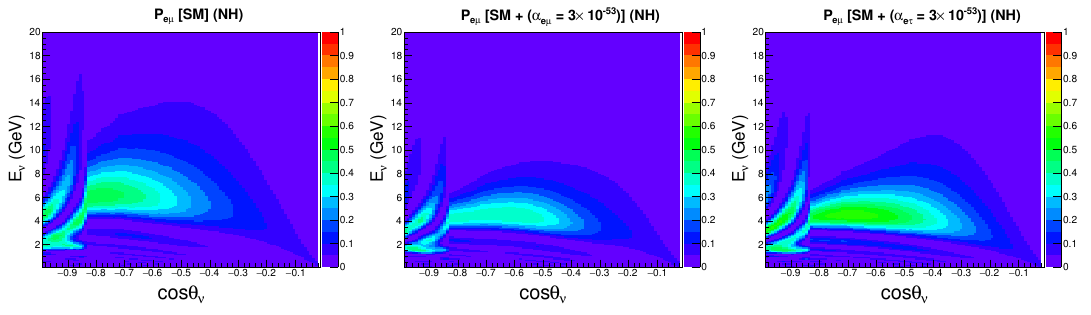
Figure 5 . The oscillograms for (cid:23) e ! (cid:23) (cid:22) channel in E (cid:23) , cos (cid:18) (cid:23) plane for three di(cid:11)erent scenarios: i) (cid:11) e(cid:22) = (cid:11) e(cid:28) = 0 (the SM case, left panel), ii) (cid:11) e(cid:22) = 3 (cid:2) 10 (cid:0) 53 , (cid:11) e(cid:28) = 0 (middle panel), and iii) (cid:11) e(cid:22) = 0, (cid:11) e(cid:28) = 3 (cid:2) 10 (cid:0) 53 (right panel). Here, in all the panels, we assume